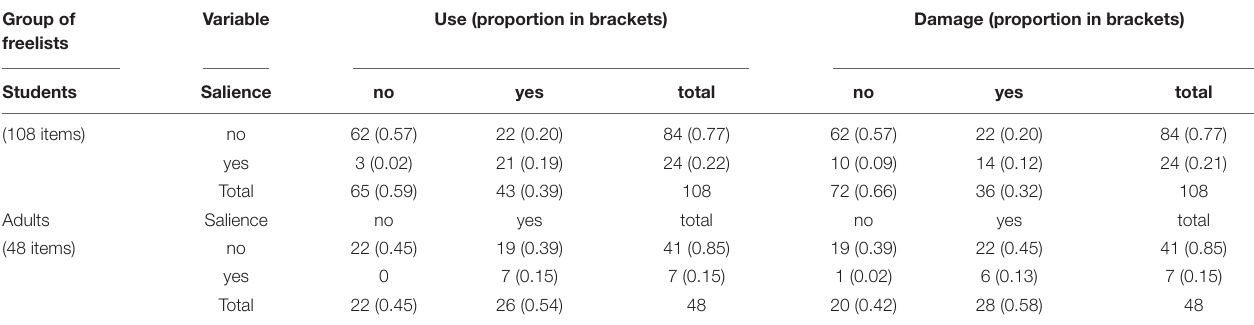
TABLE 5 | Contingency tables with the count of items with use and damage reports included in free lists. Group of freelists